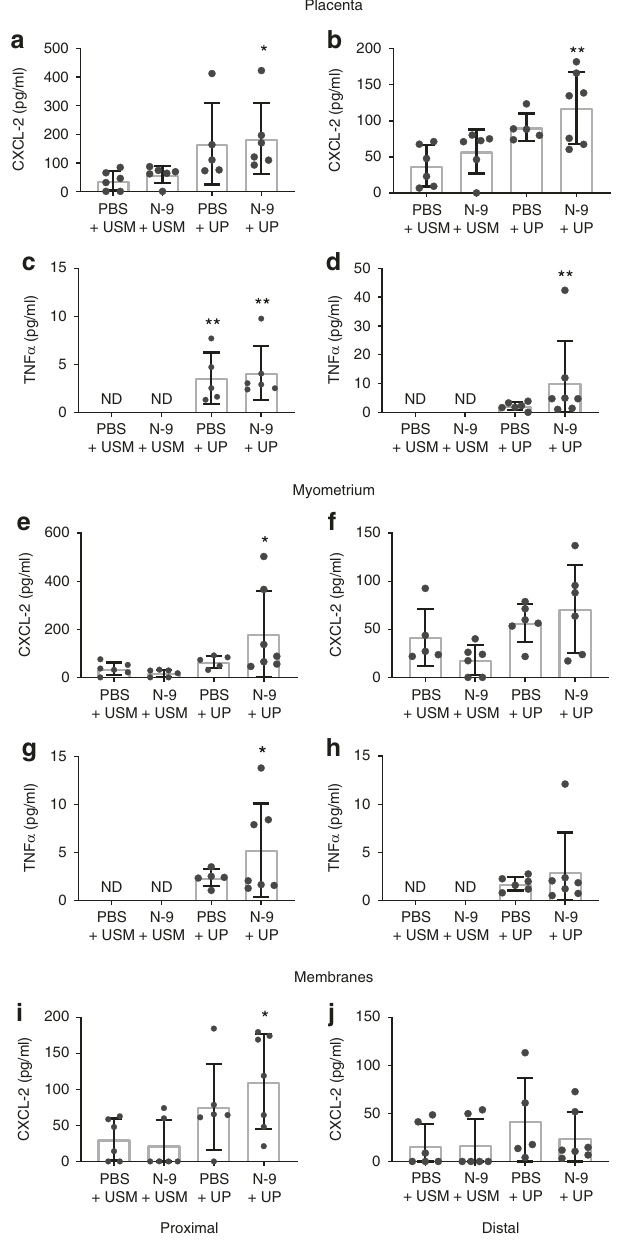
directly into the uterine horn. UP-mediated cytokine upregula- tion appears to be mediated via TLR signalling. In vitro studies using a range of cells, including human kidney cells 63 , cord blood monocytes 64 and human amniotic epithelial cells 65 , have shown upregulation of TNF α , IL-1 β , IL-6 and IL-8 (the latter being the human ortholog of CXCL-1 and CXCL-2). Use of small inter- fering RNA to knock down TLR responses to UP in human amniotic epithelial cells have identi fi ed a key role for TLR2, TLR6 and TLR9 in cytokine induction. This could be the pathway of Ureaplasma spp.-induced PTB, as these cytokines are known stimulators of the labour-inducing prostaglandins E 2 and F 2a and their synthesising enzyme COX-2 66,16 . Furthermore, induction of several MMPs, known to be important to parturition remodelling of the cervix for birth by cytokines has also been reported 17,67 . Increased amniotic fl uid MMP-9 levels have been reported for UP-positive spontaneous PTBs, but not with induced PTB or spontaneous PTB with negative Ureaplasma cultures 68 .